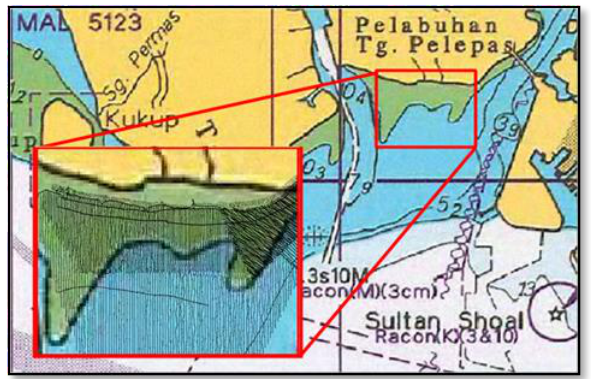
Figure 8. The overview of the in-situ bathymetry survey data.